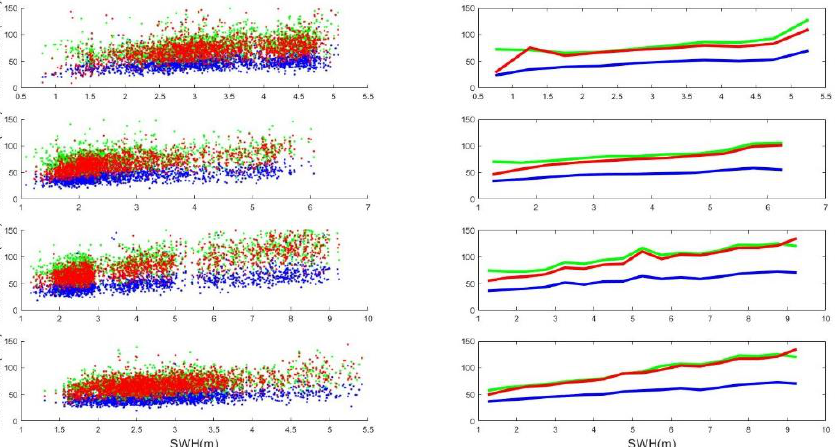
Figure 3. Standard deviation of retracked height with respect to EGM2008 for HY-2 sample passes. Left figures: statistics for individual points. Right figures: medians over 0.5 m SWH intervals (red: height from sensor geophysical data record; green: height from first step of two-pass retracking; blue: height from second step of two-pass retracking).